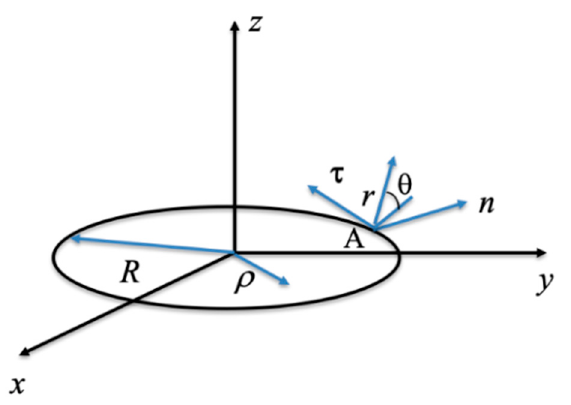
Figure 10. Model of hydraulic fracture as a disc-like crack of radius R .